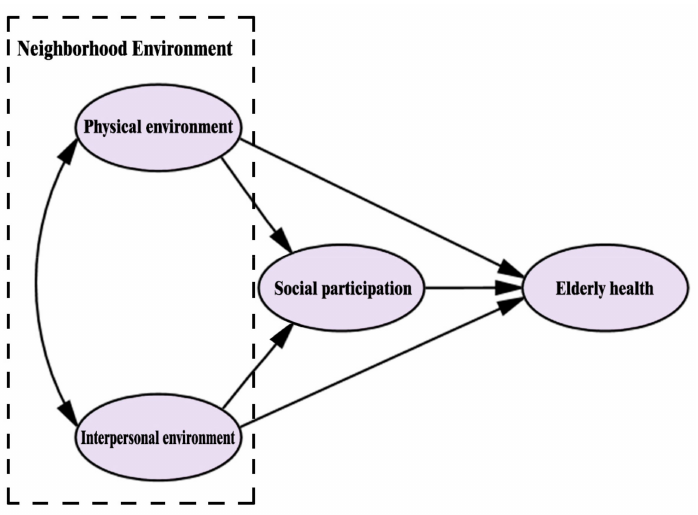
Figure 1. Construction of the concept